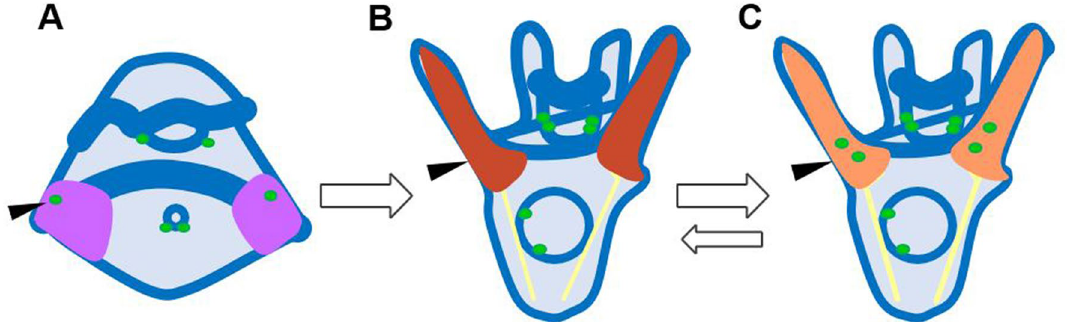
Figure 6. Model for the evolution of post-oral arm elongation and dopaminergic development. The change in the signaling milieu [pink ( A ) to red ( B )] that allowed for earlier elongation of the post-oral arms likely also inhibited the early development of dopaminergic neurons (green circles) in the lateral ganglia (black arrows). Another shift in signaling or relaxation of pleiotropy at the base of the regular urchins restored early dopaminergic development ( C ). Dynamic evolution within the regular urchins suggests that there may also be shifts back to the prior evolutionary state ( B